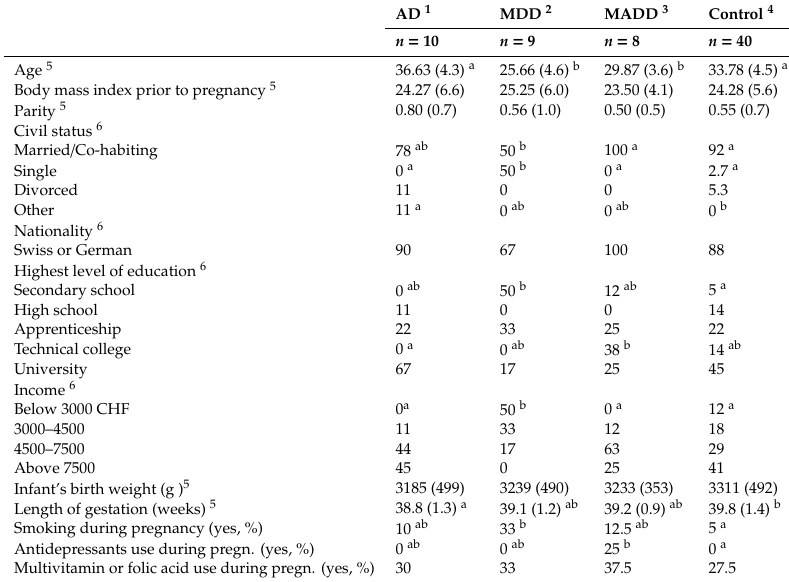
Table 1. Sociodemographic characteristics of the study population ( n =